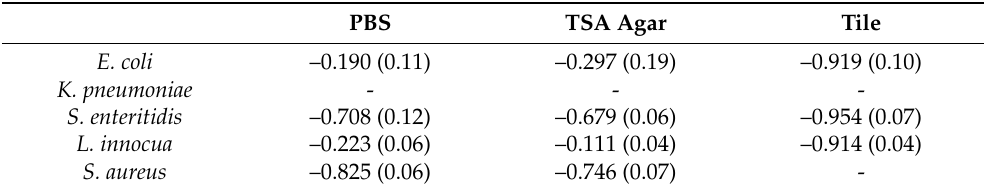
Table 1. Summary table of log reduction values depending on microorganisms at 4.5 mJ/cm 2 energy density (exposure time of 1 s). Standard deviation values are shown in brackets.